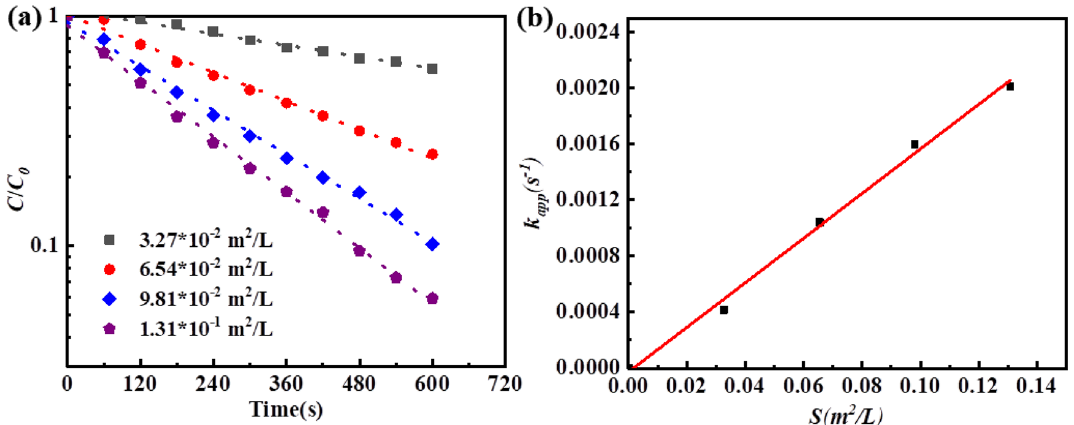
function of surface area S of Au nanoparticles normalized to the unit volume of the ) as a app